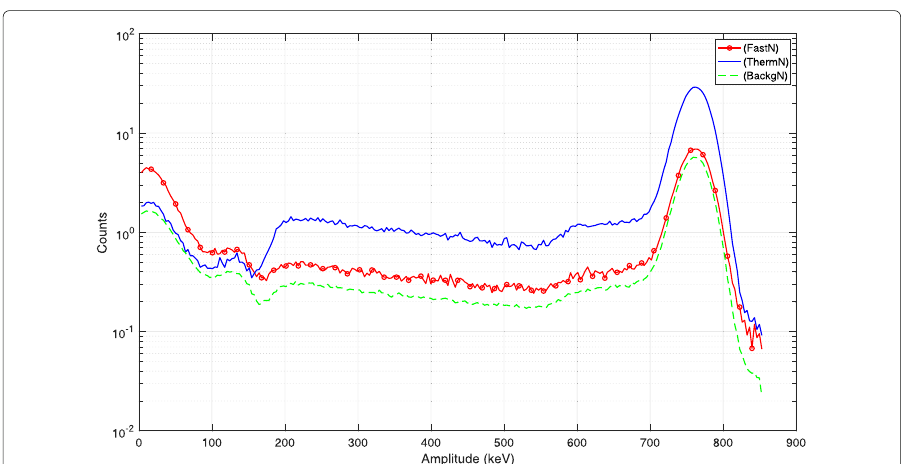
Fig. 11 Measured PHS normalized by time and solid angle, obtained in configuration (FastN), (ThermN) and